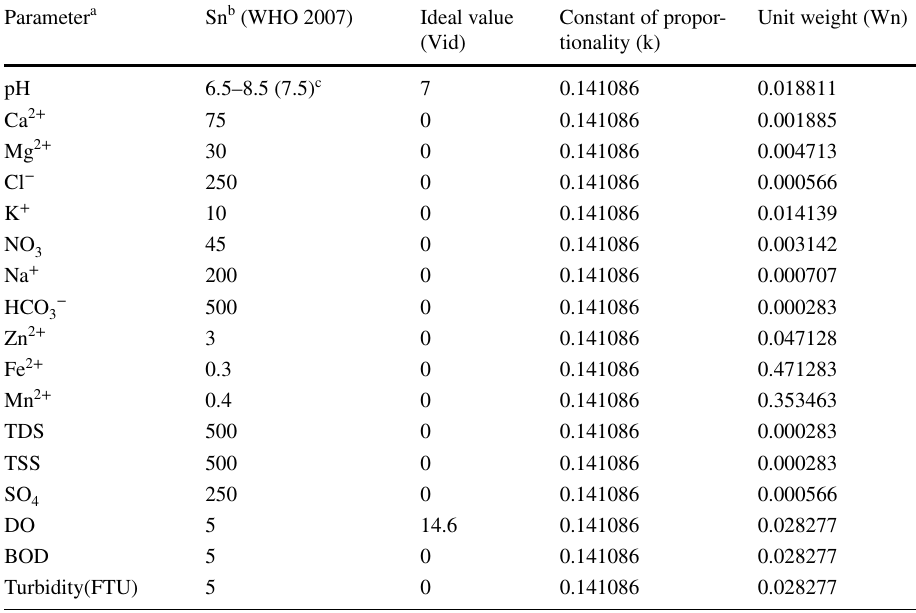
Table 4 Standard values of water quality parameters and their corresponding ideal values and generated unit